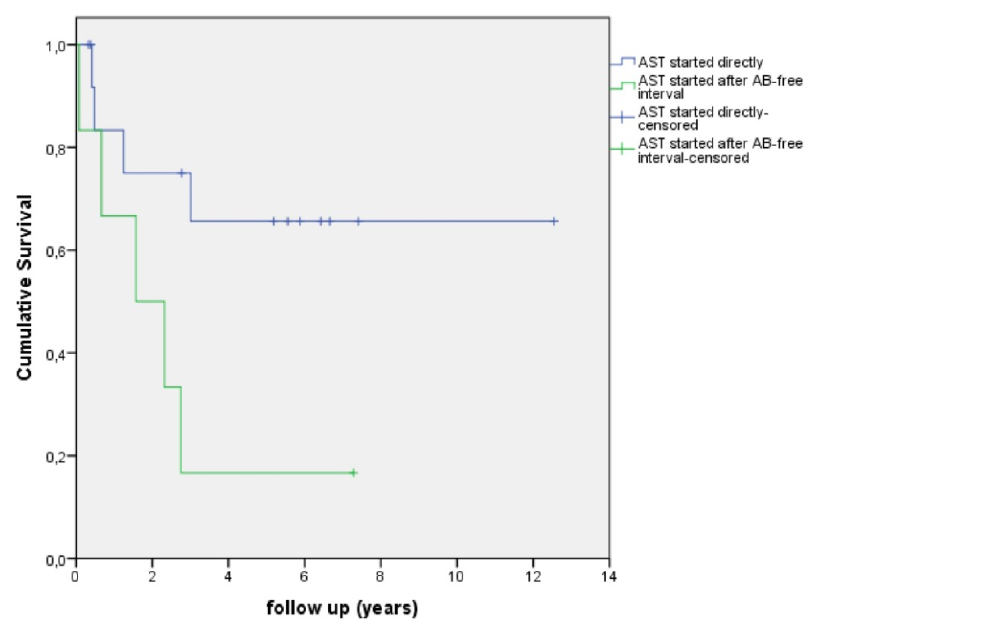
Figure 3. Kaplan-Meier curve showing survival/time without an event, S. aureus vs other causative microorganisms.